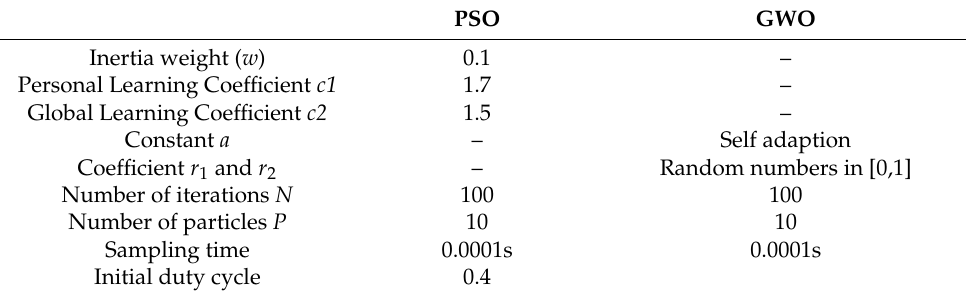
Table 3. Parameter of the PSO and GWO MPPT algorithms.